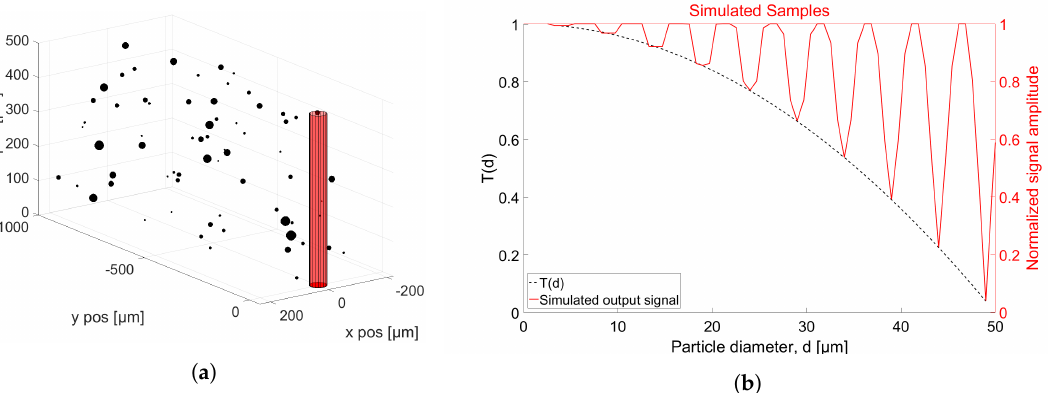
Figure 5. ( a ) a defined oil volume with a number of uniformly distributed particles; ( b ) verification that the normalized simulation output follows the theoretical derivation of the transmission factor T , through sampling of 10 different-sized particles (red solid line) and comparing with the calculated transmission factor, T , as a function of particle diameter (black